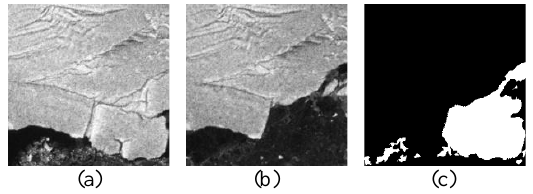
Figure 4. Sulzberger dataset. (a) Image acquired on March 11, 2011. (b) Image acquired in on March 16, 2011. (c) Ground